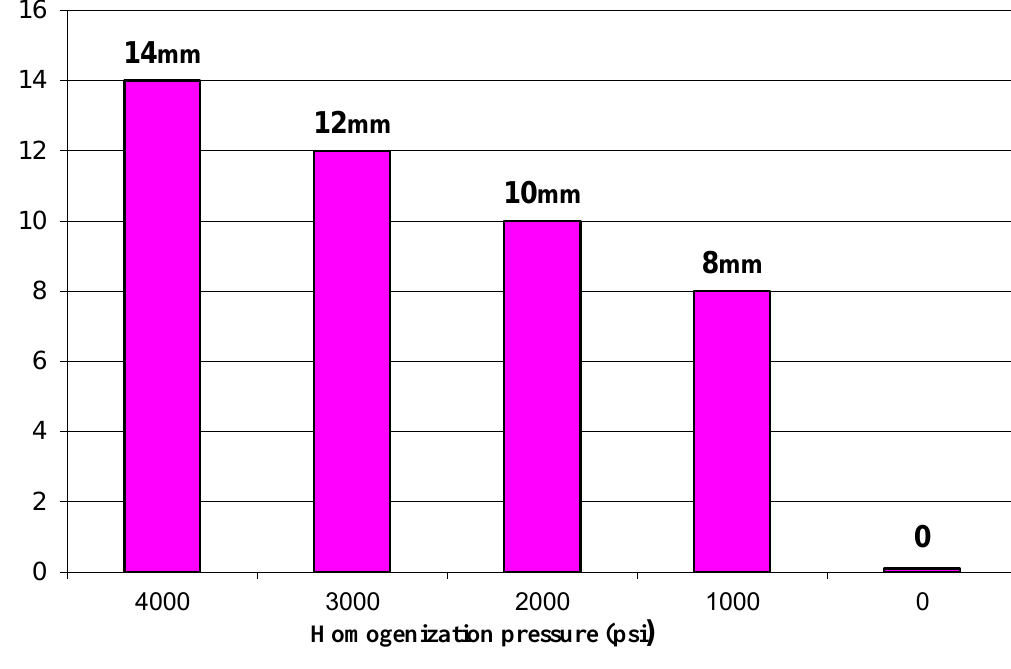
Figure, 2: The antimicrobial spectrum of crude bacterocin produced by L. acidophilus LA-K against stressed E. coli O157: H7 by pressurizatioin